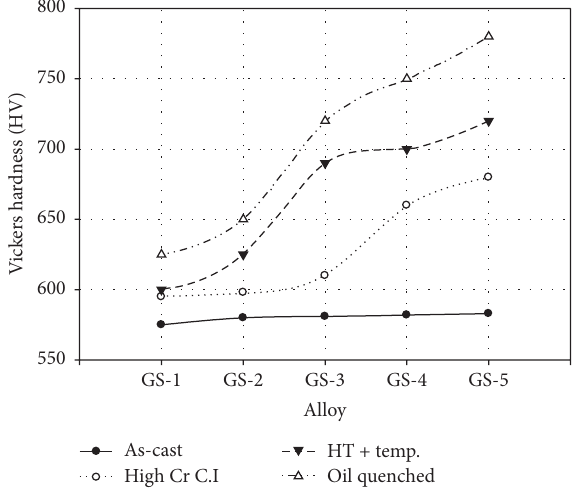
Figure 11: Industrial performance of GS alloys compared with Mn- modified steel and Cr cast